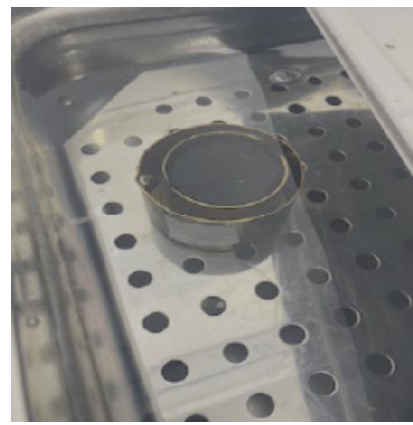
Figure 13. Putting the sample (with 15% polymer) in water path